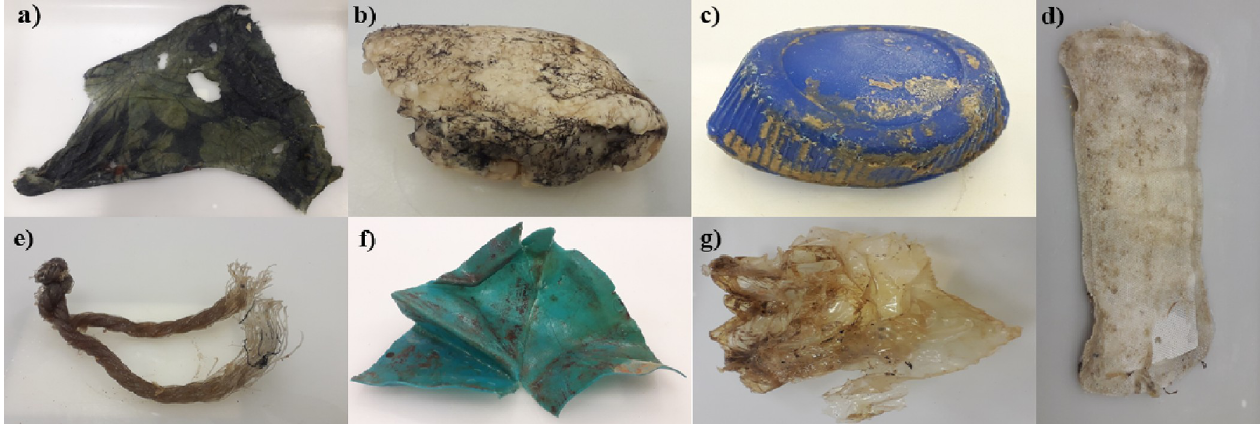
Fig 2. Different sampled litter types showing biofilm that was scratched for eDNA extraction. a) Fabric piece b) Expanded polystyrene c) Plastic bottle d) sanitary pad e) Fishing gear f) Plastic fragment g) Plastic bag.